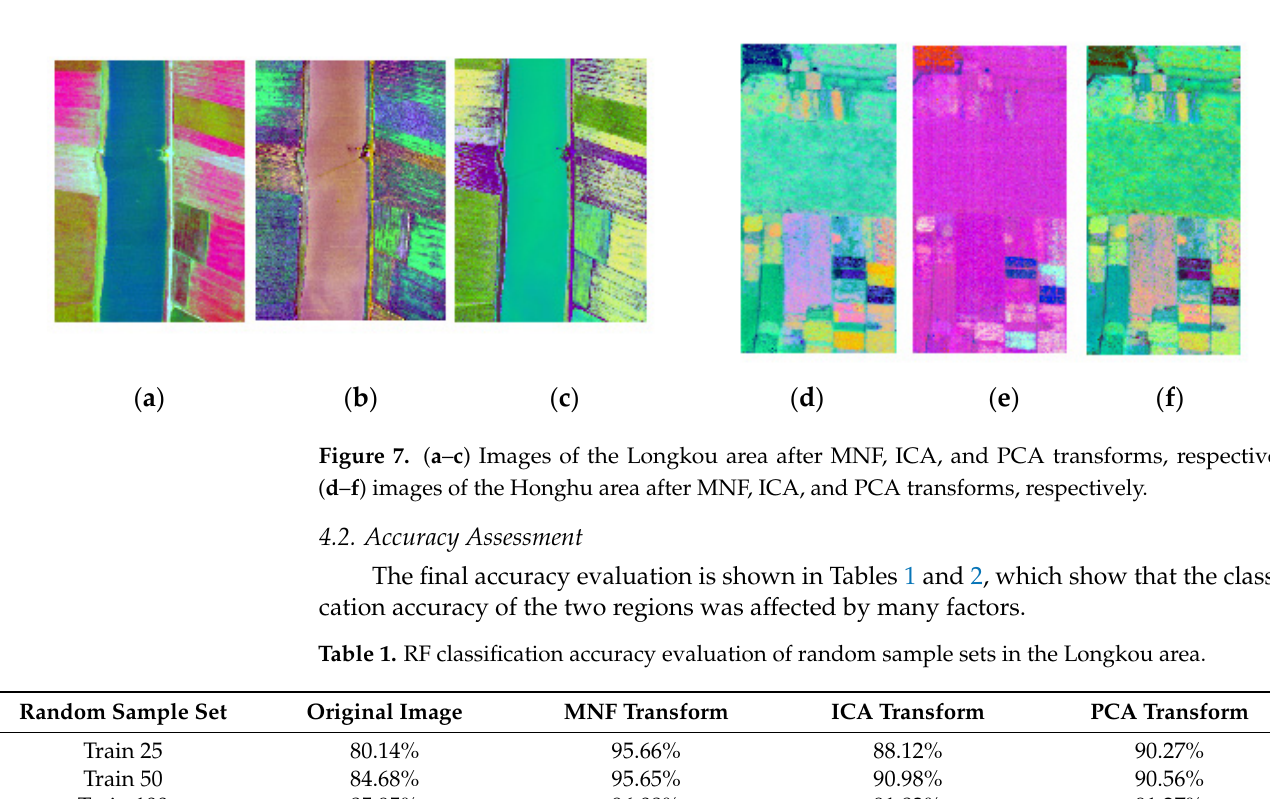
Figure 6. ( a – c ) The MNF transform at 19 bands, ICA transform at 19 bands, and PCA transform at 13 bands, respectively, in the Longkou area; ( d – f ) the MNF transform at 19 bands, ICA transform at 45 bands, and PCA transform at 9 bands, respectively, in the Honghu area.